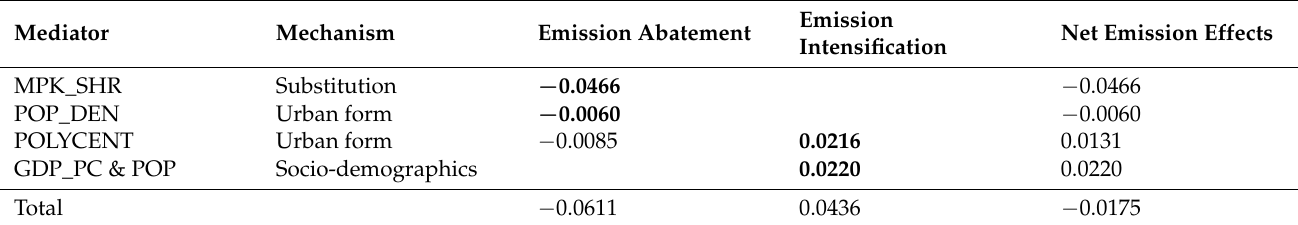
Table 5. Emission effects of urban rail transit through different intermediate